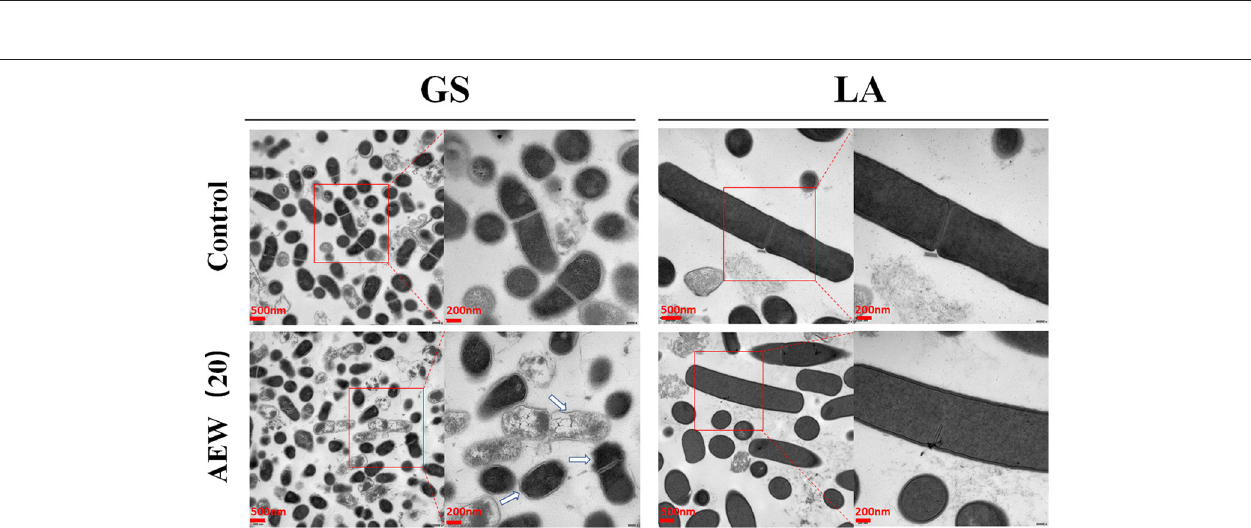
Frontiers in Medicine | www.frontiersin.org